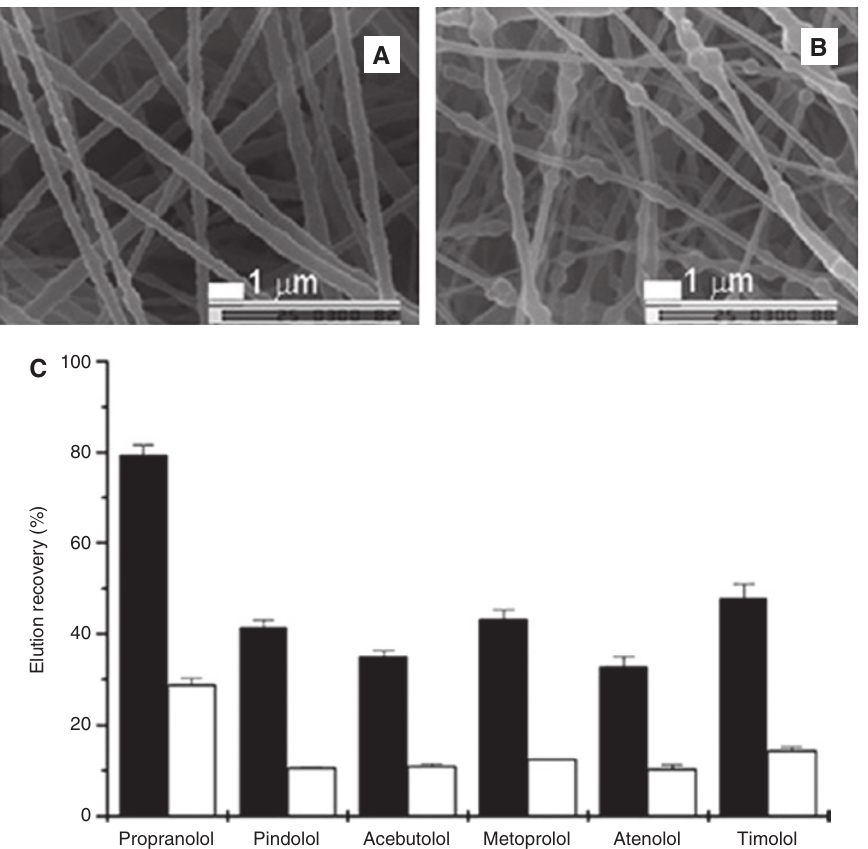
Figure 20: 2 SEM images of electrospun nanofiber membranes containing (A) 50% of imprinted nanoparticles, (B) 50% of non-imprinted nanoparticles. (C) Selectivity of nanofiber-based SPE. Recovery of β -antagonists at the elution step from the imprinted (solid) and the non- imprinted nanofiber(open). For details, see Ref. [86]; reprinted with permission from